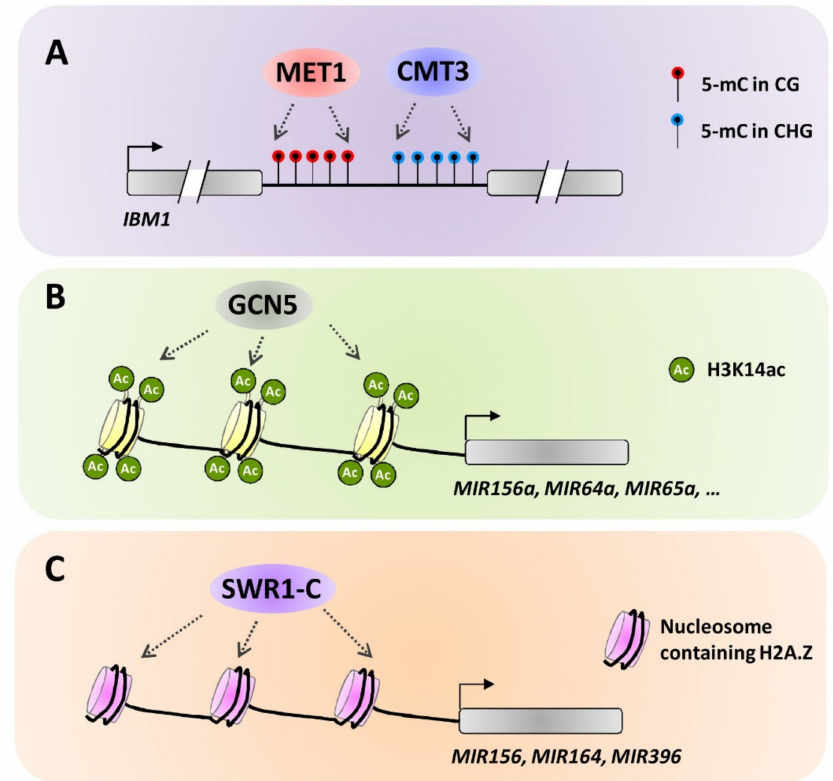
Figure 3. Simplified models for the transcriptional mechanisms of epigenetic interplays. ( A ) Ara- bidopsis DNA methyltransferase MET1 and plant-specific chromomethylase CMT3 directly regulate expression of the H3K9 demethylase gene IBM1 by mediating CG and CHG methylation in a large intron of IBM1 . ( B ) GCN5-mediated histone H3K14 acetylation positively regulates